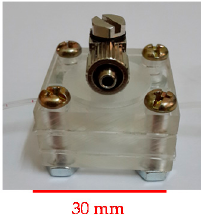
Figure 3. Close-up photograph of a valveless